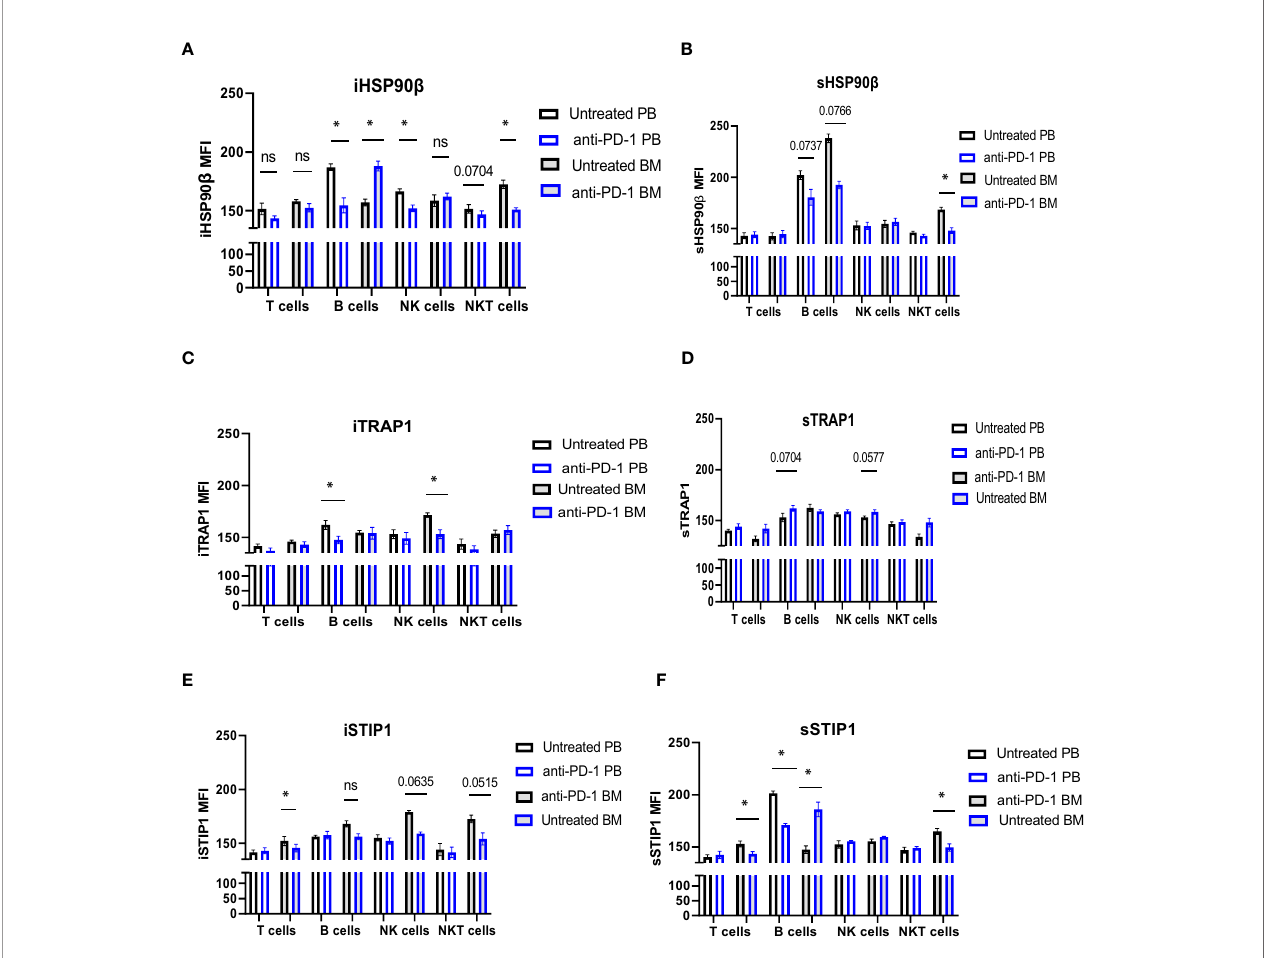
FIGURE 6 | The effect of anti-PD-1 on the HSP90 expression in PB and BM lymphocytes in r/r cHL patient. Intracellular (A, C, E) and surface (B, D, F) expression of HSP90 b (A, B) , TRAP1 (C, D) and STIP1 (E, F) in PB and BM lymphocytes in r/r cHL patient (n=1). Graphs show mean ± SD. ns, not signi fi cant, *p<0.05. PB, peripheral blood; BM, bone